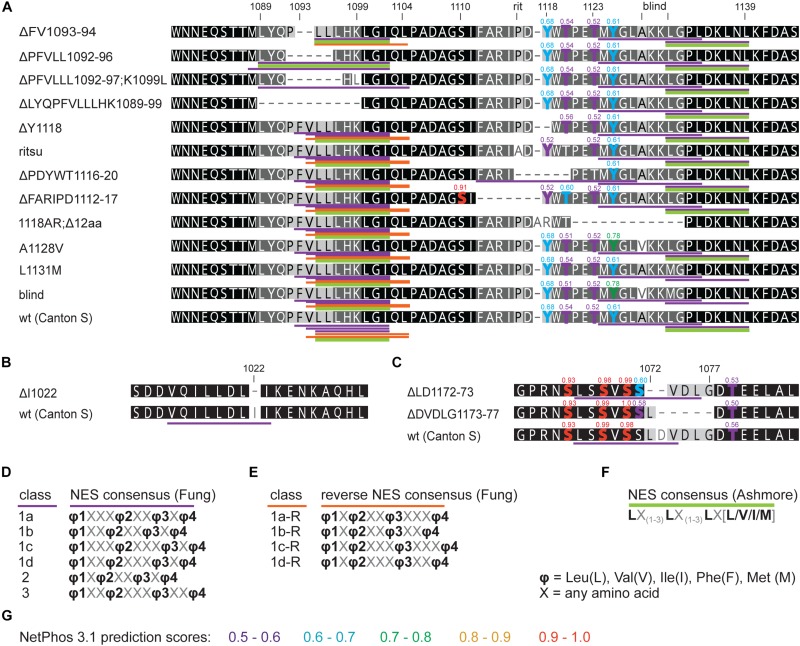
in silico prediction of nuclear export signals (NESs) and phosphorylation in tim mutants. Protein alignments of (A)
ritsu, blind, and NES 1093-1104 regions, (B) NES 1015-1023, and (C) NES 1166-1174 with underlined NES motifs. Purple, orange, and green colors code for NES classes according to consensus shown in D–F. Residues which phosphorylation is possibly affected by mutation are highlighted in the alignment and scores are indicated above the amino acid. (G) The colors correspond to prediction from NetPhos 3.1.